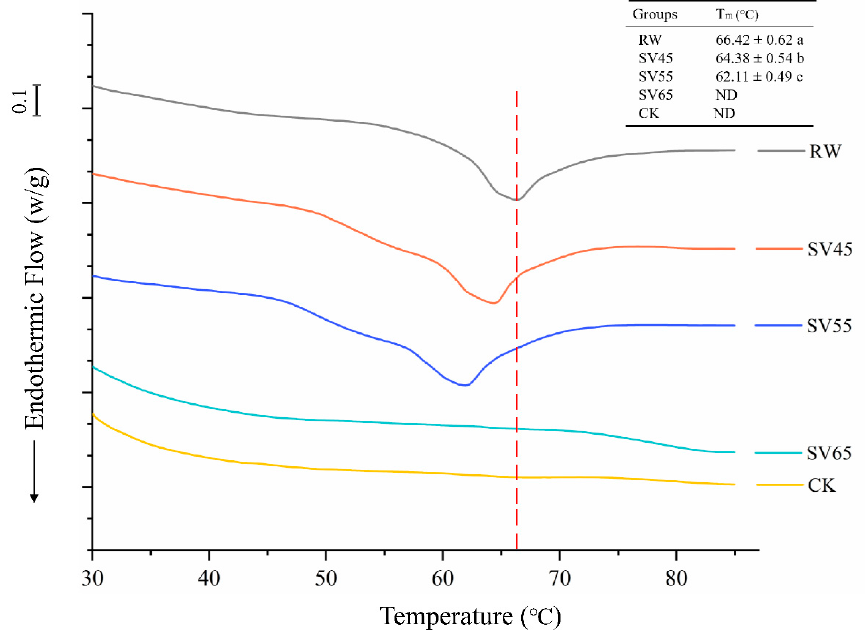
Figure 3. DSC endotherm of collagen from RW, CK and SV sample. Different letter (a–c) in the same column indicates statistically significant differences ( p < 0.05, n = 5).